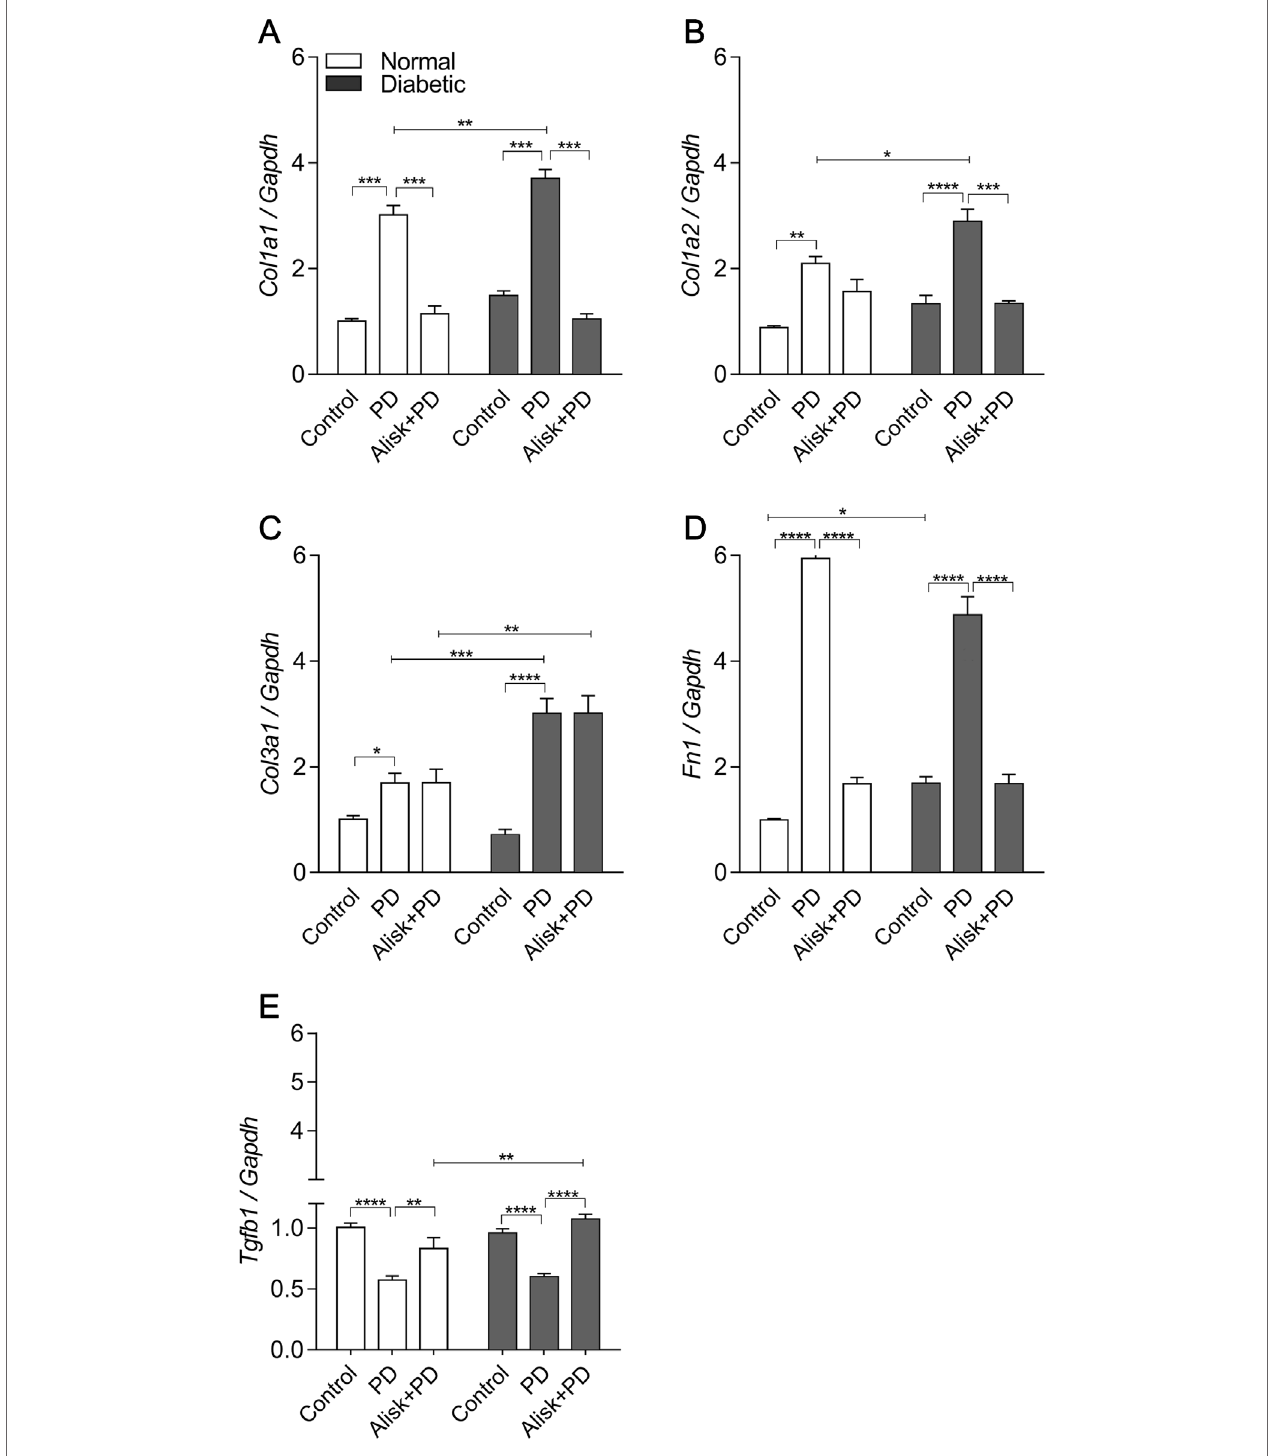
FIGURE 5 | Col1a1, Col1a2, Col3a1, Fn1, and Tgfb1 gene expression of gingival tissue from normal and diabetic mice at 14 days after PD regardless of the fact if they were treated or not with aliskiren. (A) Col1a1, (B) Col1a2, (C) Col3a1, (D) Fn1, and (E) Tgfb1 in gingival tissue of control normal, normal with PD, normal with PD treated with aliskiren, control diabetic, diabetic with PD, and diabetic with PD treated with aliskiren by real-time RT-PCR. Results express mean ± SEM, normalized by fold change. Significant values are represented by p < 0.001, **p < 0.05, ***p < 0.005, and ****p < 0.0001 (Control vs. PD, PD vs. Alisk+PD, PD vs. PD, and PD+Alisk vs.